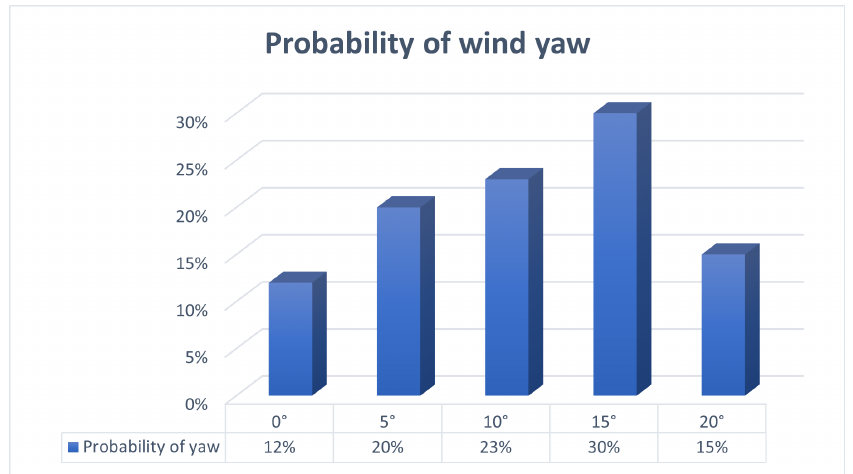
Figure 9. Probability of wind yaw at IM